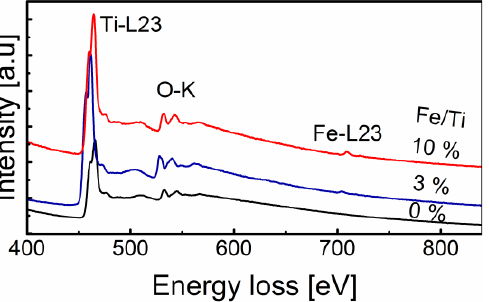
Figure 6. Core-loss EELS analysis of TiO 2 and Fe-TiO 2 samples. Spectra contain edges of all elements present in these samples.